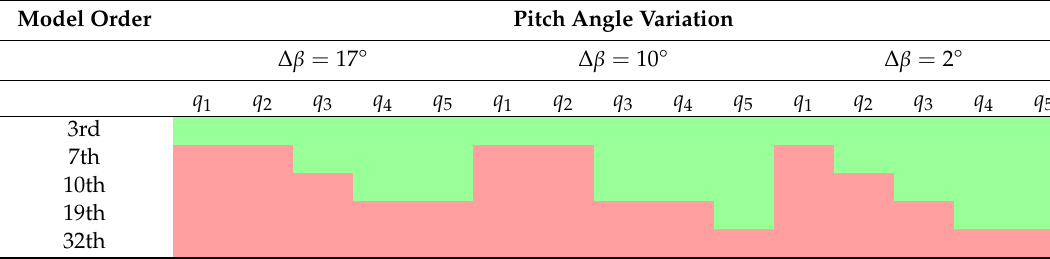
Table 6. Kharitonov stability